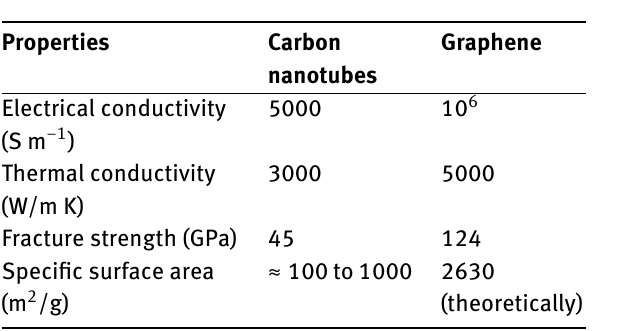
Table 4: Comparison between important properties of carbon nan- otubes and graphene.